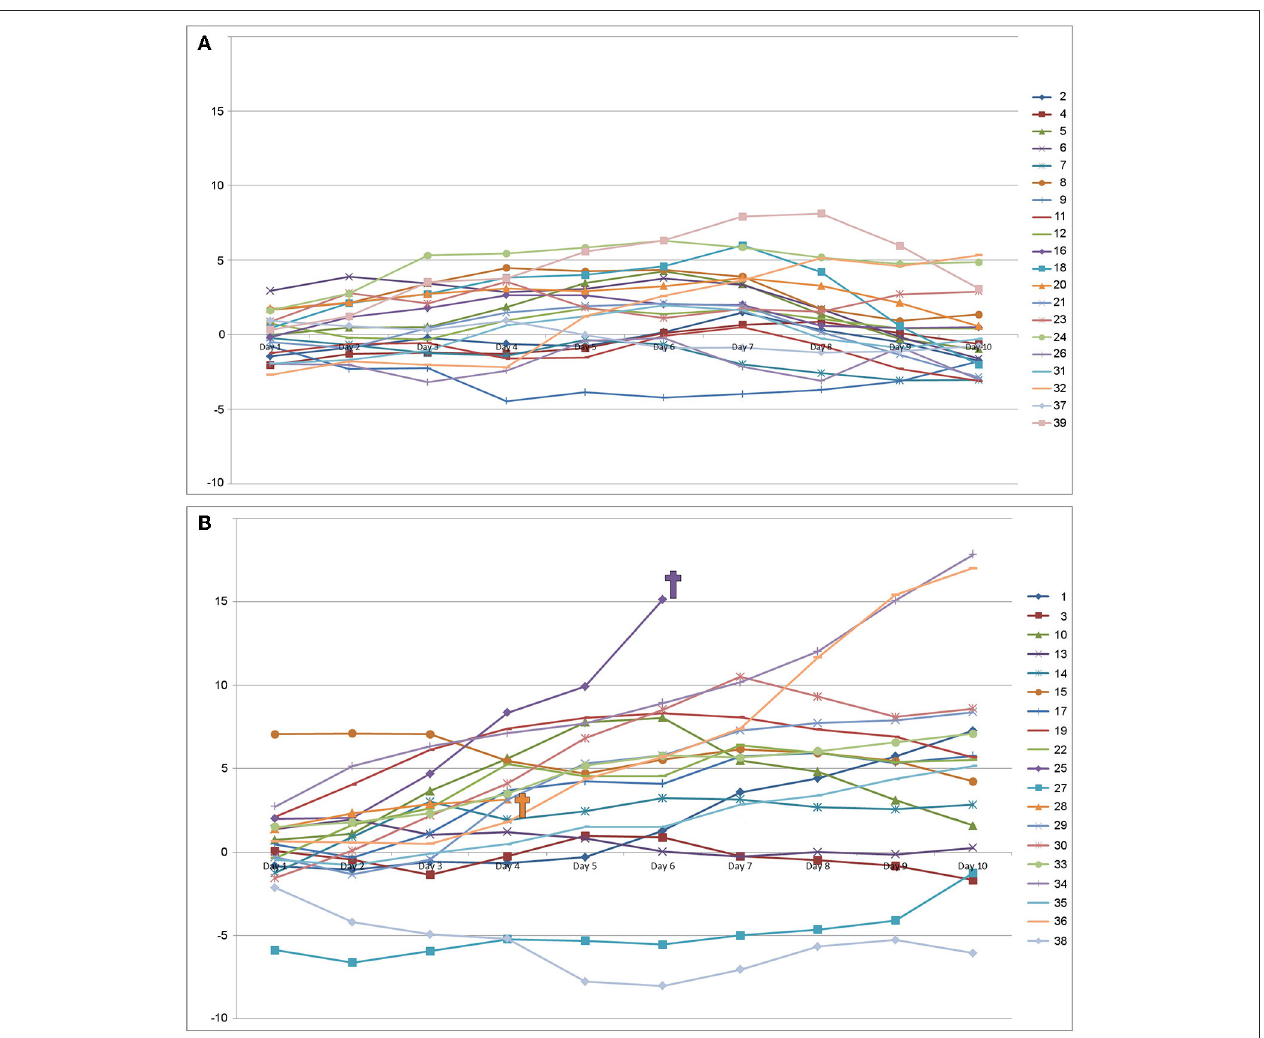
FIGURE 2 | Individual daily cumulative net fluid balance (in l) over the first 10 days after admission to the neurointensive care unit for the group with an acceptable outcome modified Rankin Scale ≤ 4 (A) , and the group with a poor outcome [modified Rankin Scale ≥ 5 (B) ].